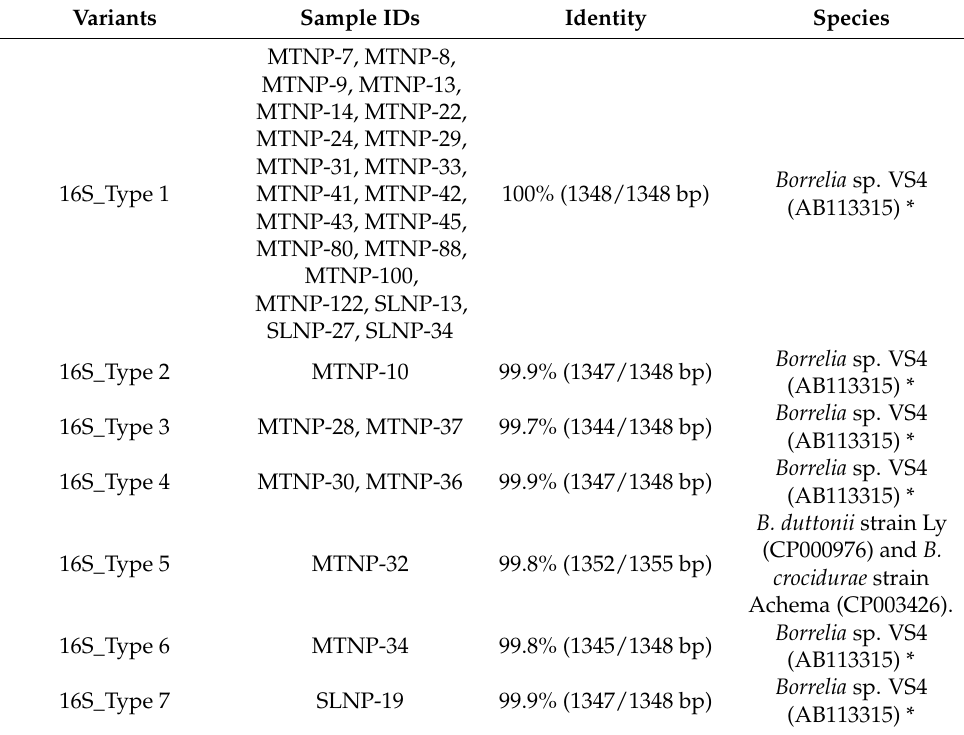
Table 3. Results of BLASTn search of 16S ribosomal DNA